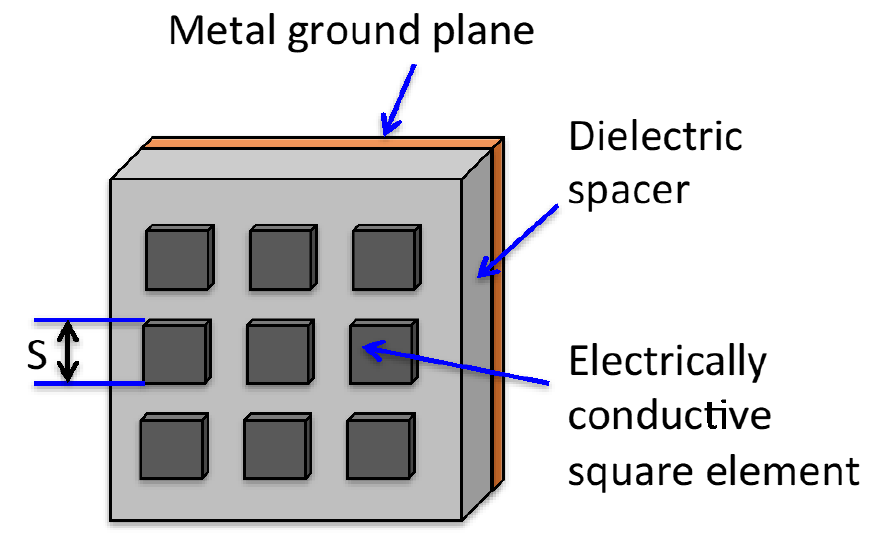
Figure 1. Schematic of a conductive square array metamaterial.